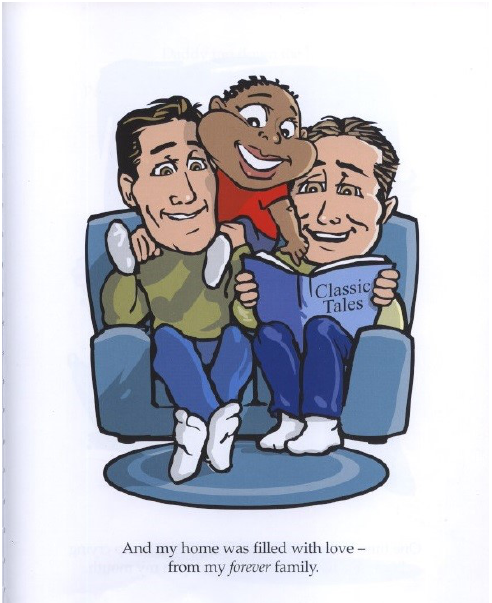
Figure 5. Aldrich’s central image mirrors the implied reception of his read along book as a practice of the entire family.